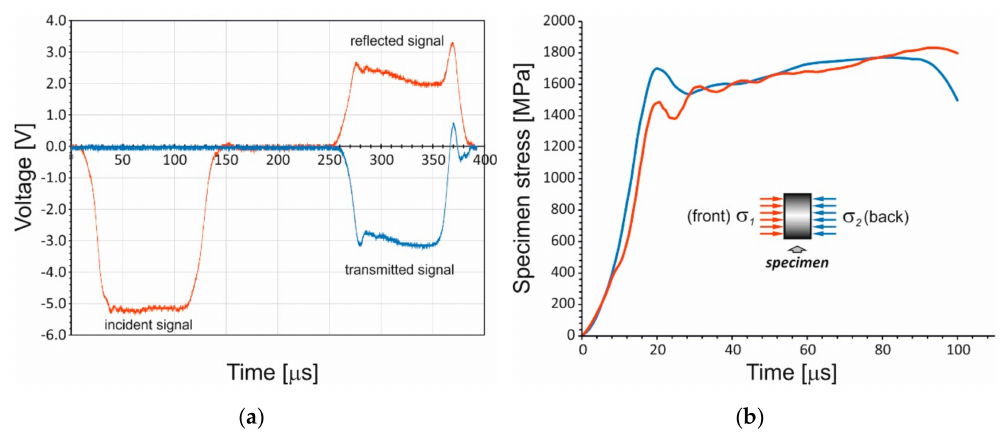
Figure 2. ( a ) Typical raw wave signals from SHPB experiment for Ti64LM; ( b ) stresses on the front and back end of Ti64LM specimen (dynamic stress